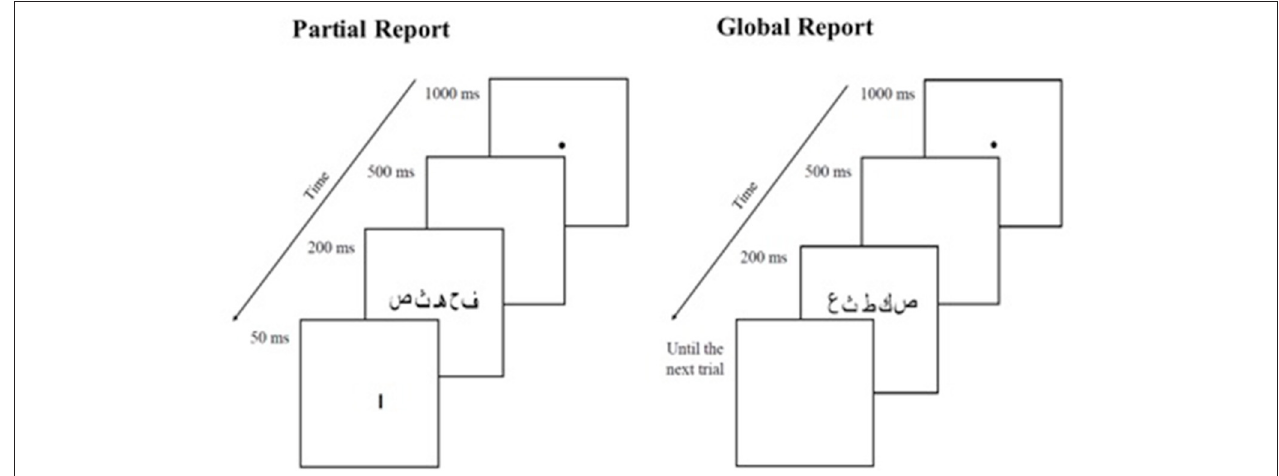
FIGURE 1 | Schematic illustration of the global and partial report tasks for the Arabic language.